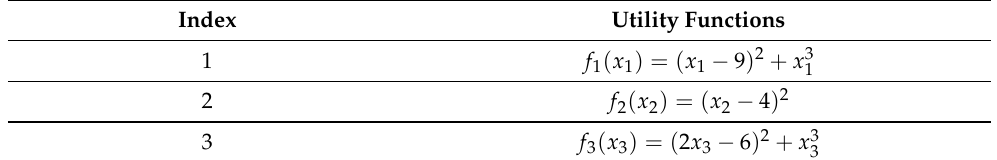
Table 1. Utility functions.